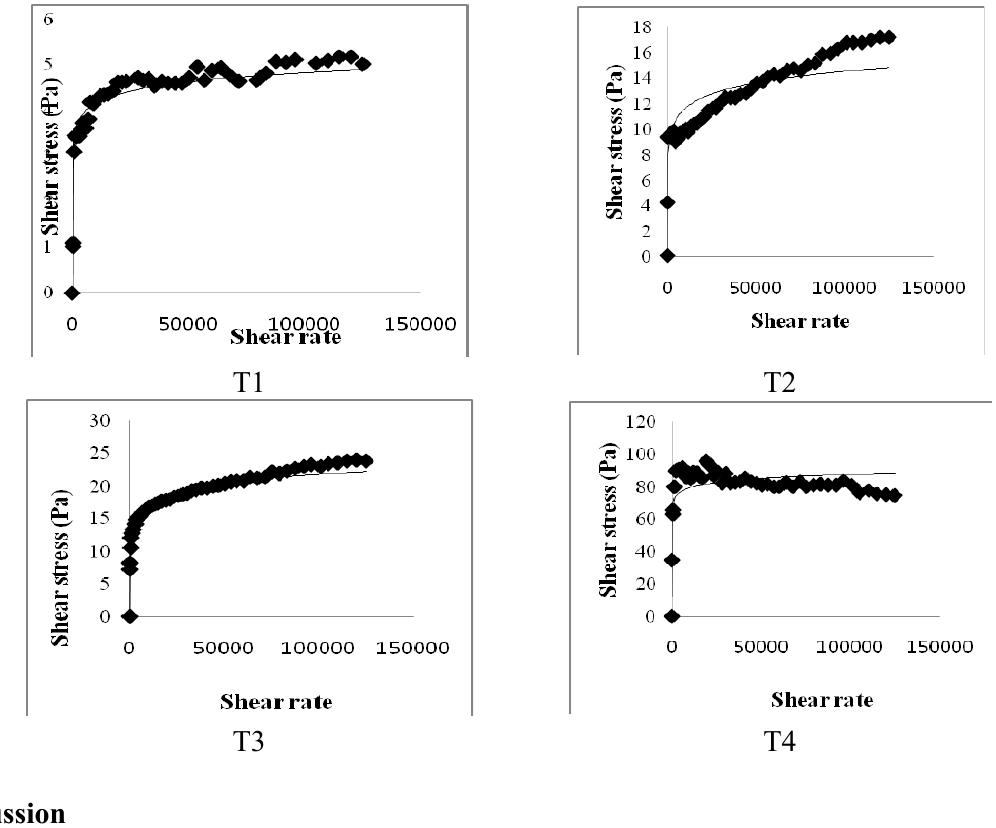
Figure 5. Effect of binding of conjugated linoleic acid with biopolymers on the viscosity of small intestine contents in mice fed high- and low-fat diets. Significance was set at p <